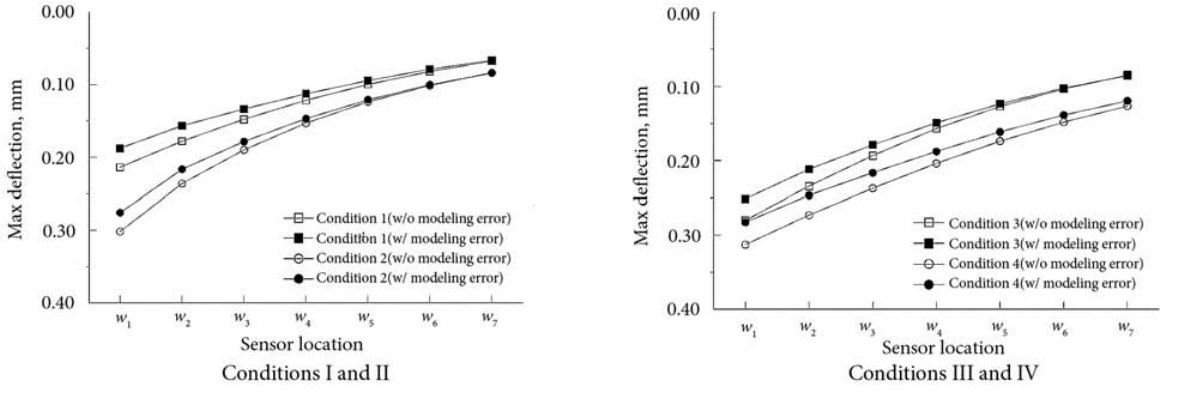
Fig. 7. Max deflection curves with and without modeling errors for integrity conditions for bedrock boundary